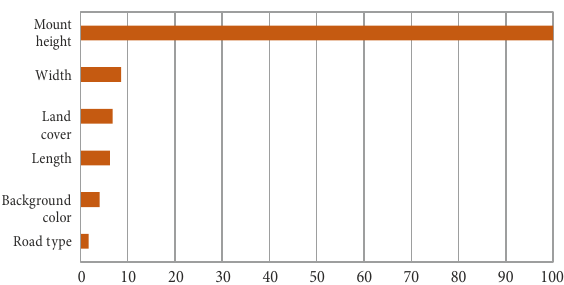
Fig. 6. Variable importance ranking for traffic sign vandalism association between mount height and vandalism rate did not seem to be linear because the rate of vandal- ism for signs installed within 5 feet of the ground was less than those between 5 and 7 feet. While the average mount height for all measured signs was about 8 feet, the average height of vandalized signs was 6.5 feet above the road. The closeness of rankings of sign size, color, land cover, and road type may indicate an inner correlation or interaction between those predictors. To enable more in-depth analysis, the possible interaction between the most important variable, sign mount height, and other factors should be studied. Fig. 7 shows the Pearson cor- relation coefficient values (the covariance of the two variables divided by the product of their standard de- viations). As seen in the figure, significant correlation between sign width and sign length is evident. The cor- relation between other variables was not significant. As shown in Fig. 8, approximately, all of the vandal- ized signs located in rural areas or installed on ramps had a mount height less than 10 feet. Thus, mounting these signs higher can be a good countermeasure against sign vandalism. In addition, 53% of vandalized signs were warning signs. Turn and curve warning signs that com- prised approximately 30% of vandalized signs, have an av- erage mount height of 6.6 feet with 1.5 standard deviation.